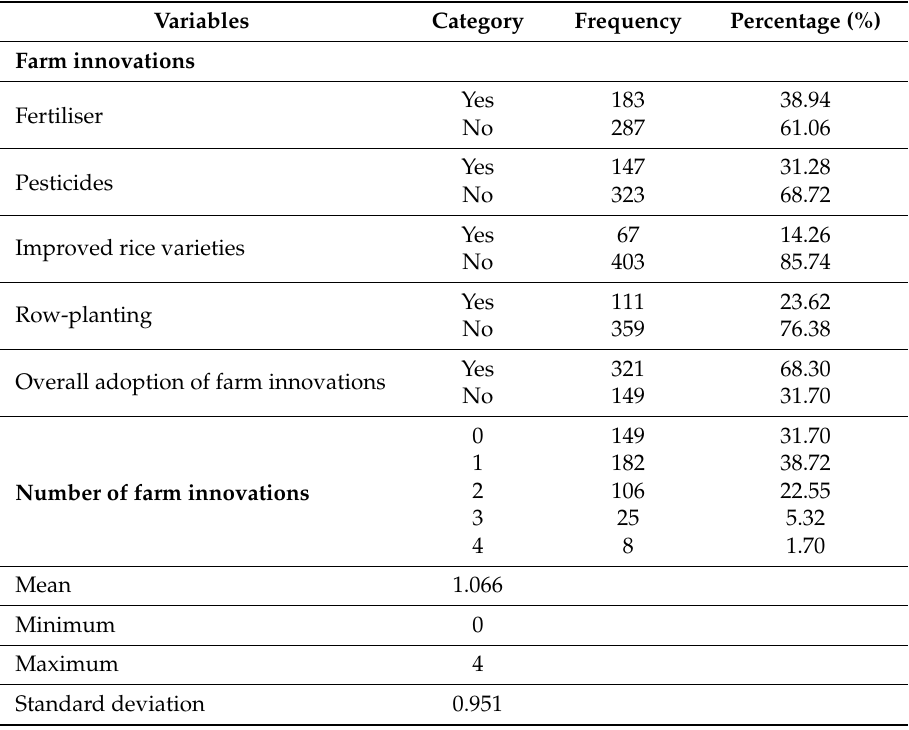
Table 1. Adoption of farm